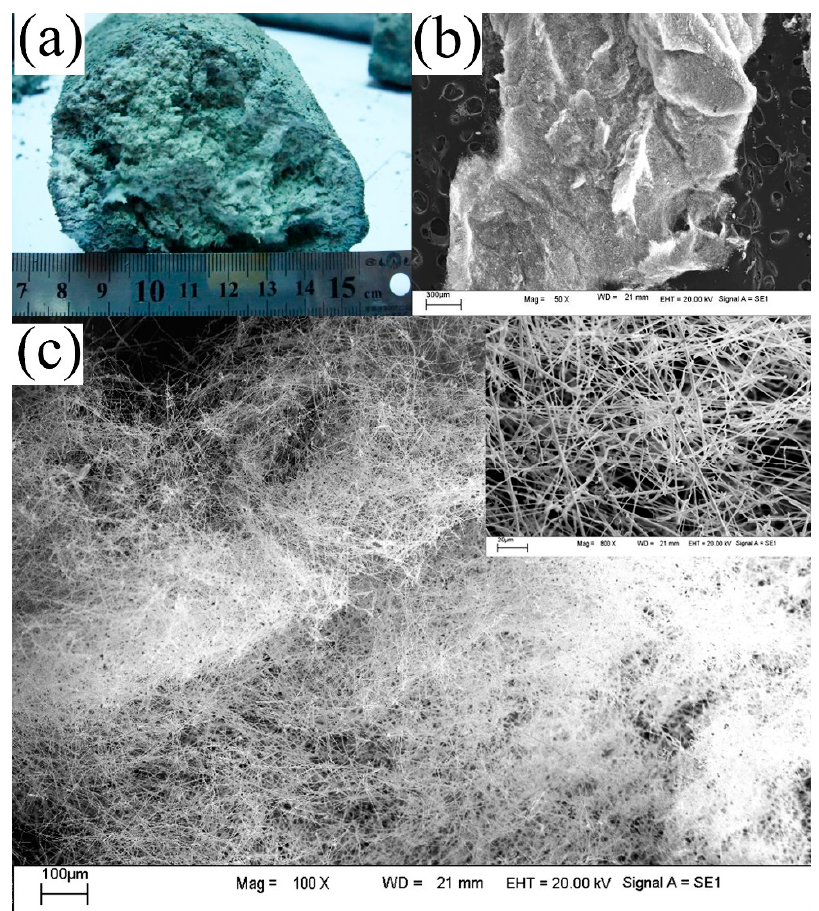
Figure 3. ( a ) Flu ff y and green colored W-catalyzed CSed SiC NWs; ( b , c ) typical SEM images of the W-catalyzed CSed SiC NWs.